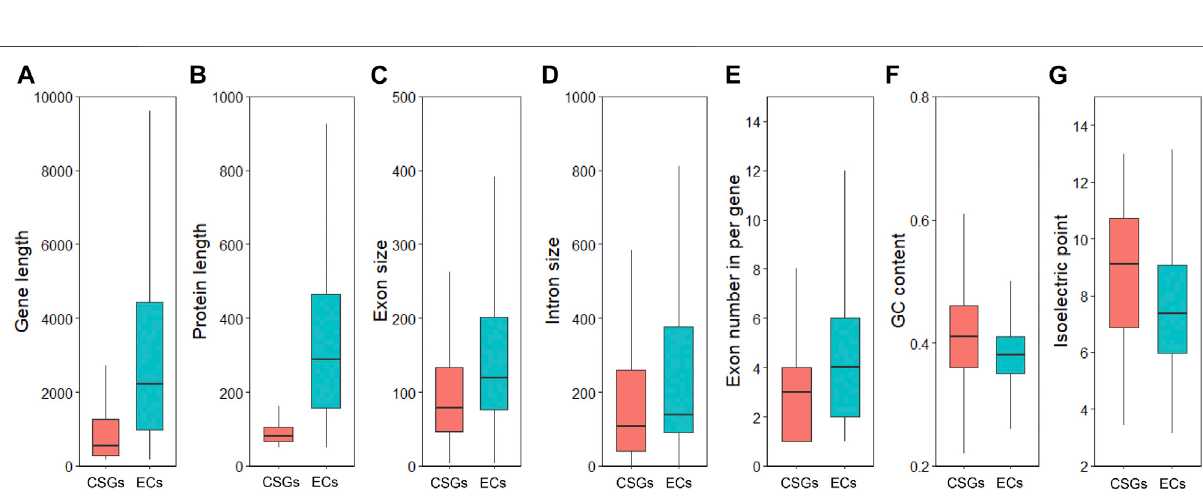
Frontiers in Genetics |